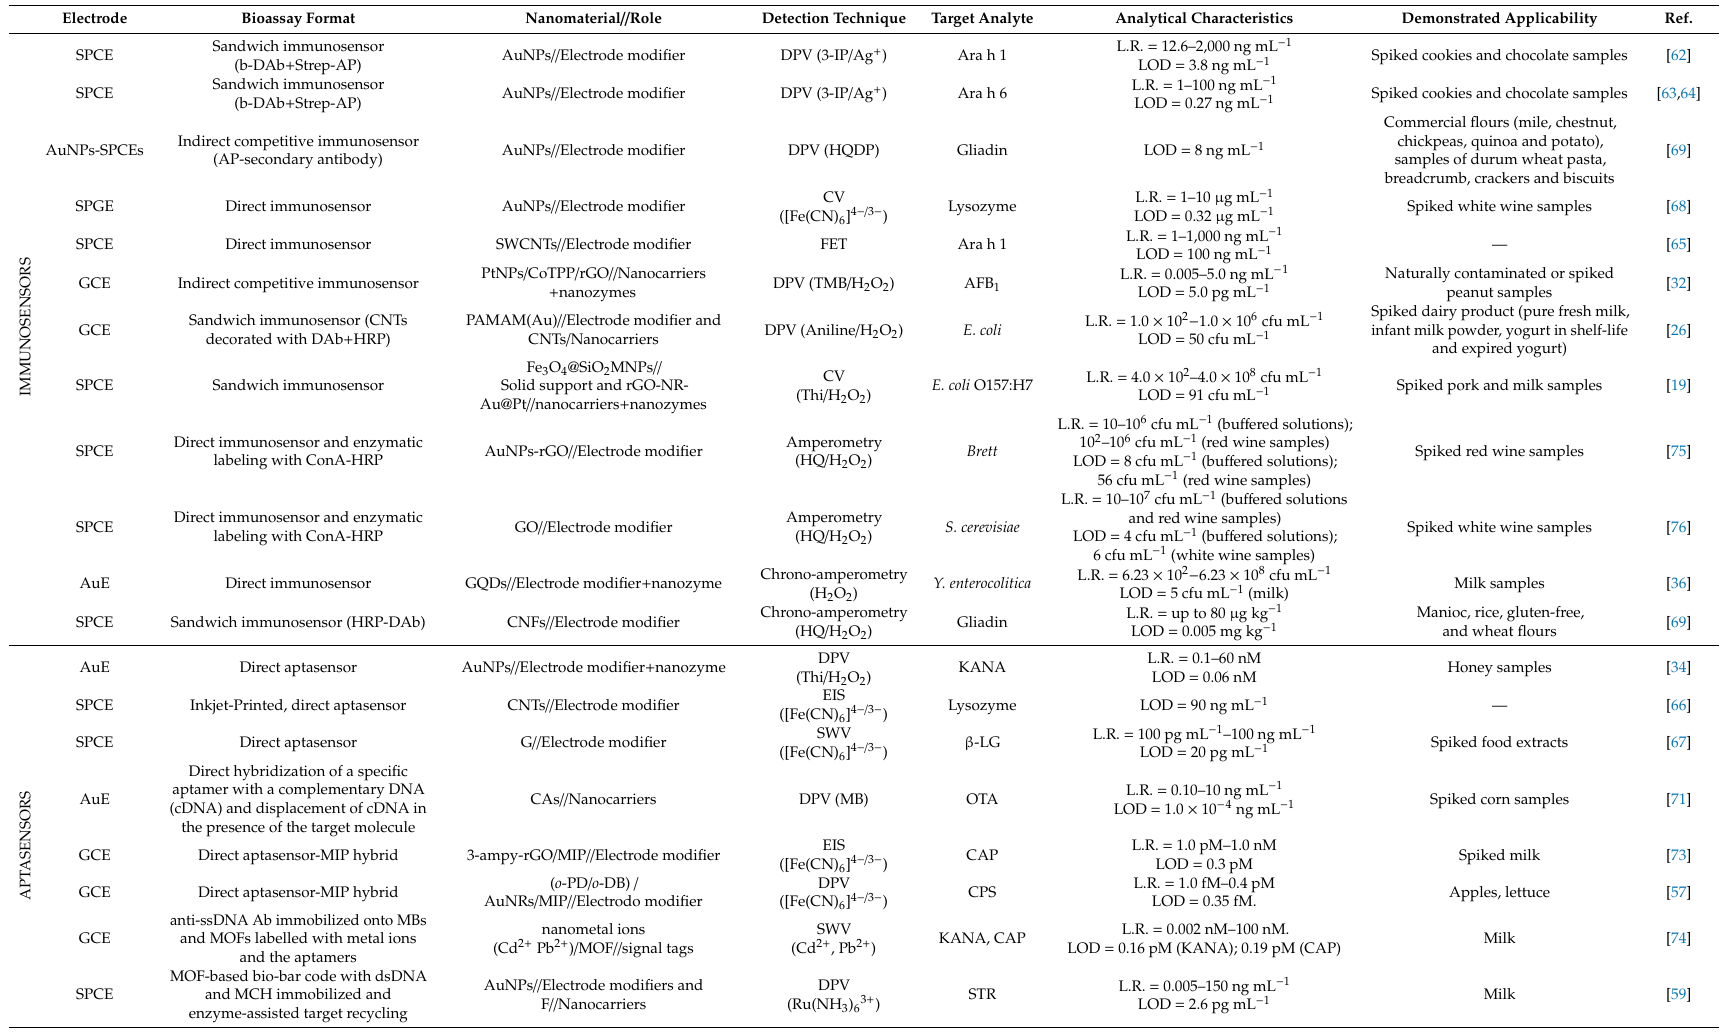
Table 1. Electrochemical biosensors and biosensing methods involving selected nanomaterials for food monitoring reported since